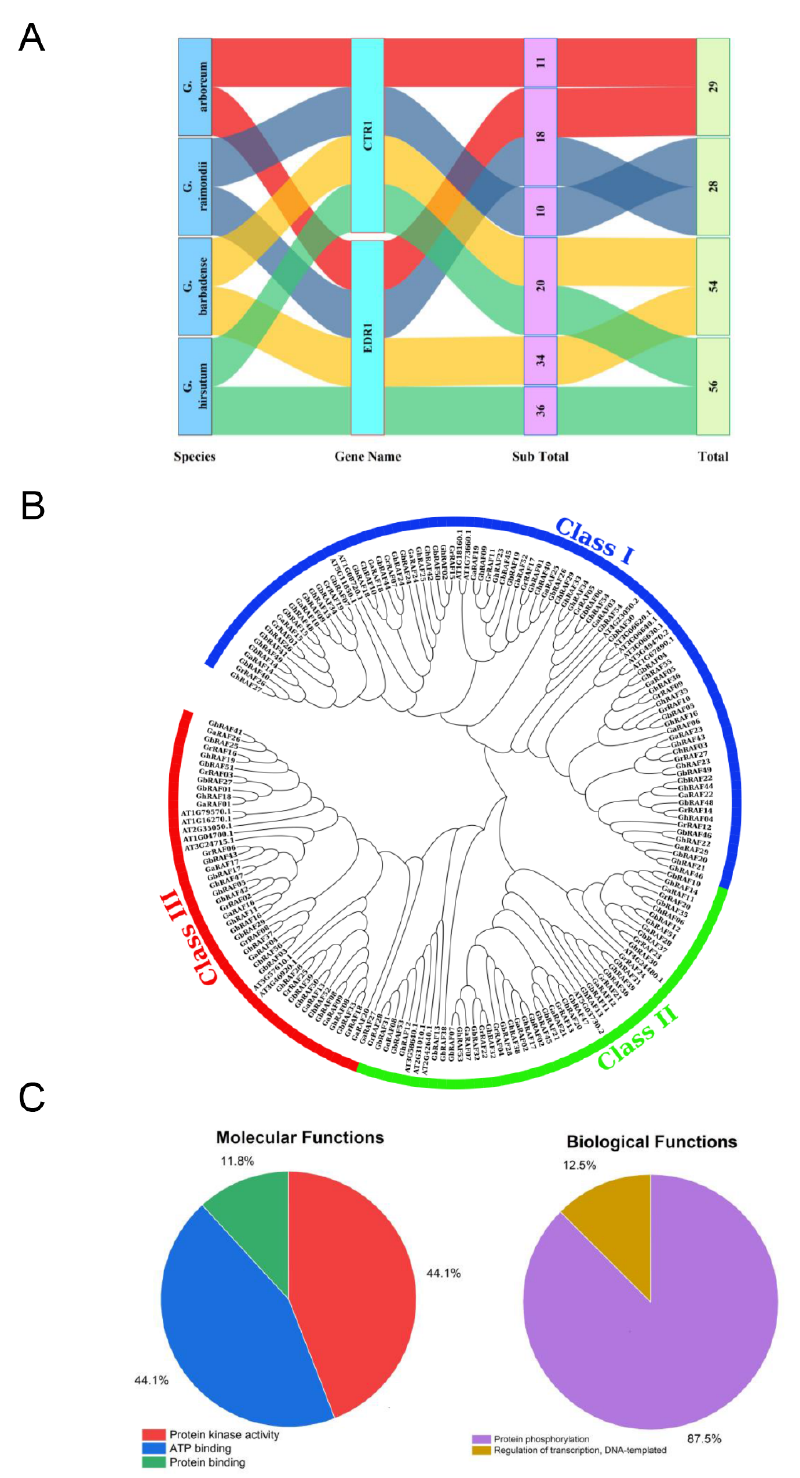
Figure 1. Salient features of The Raf-like kinase B-subfamily (RAF) genes and types, RAF genes phylogenetic analysis in four species of cotton and study of gene ontology ( A ) Description of RAF genes ( B ) Phylogenetic analyses ( C ) Gene ontology enrichment of GhRAFs .